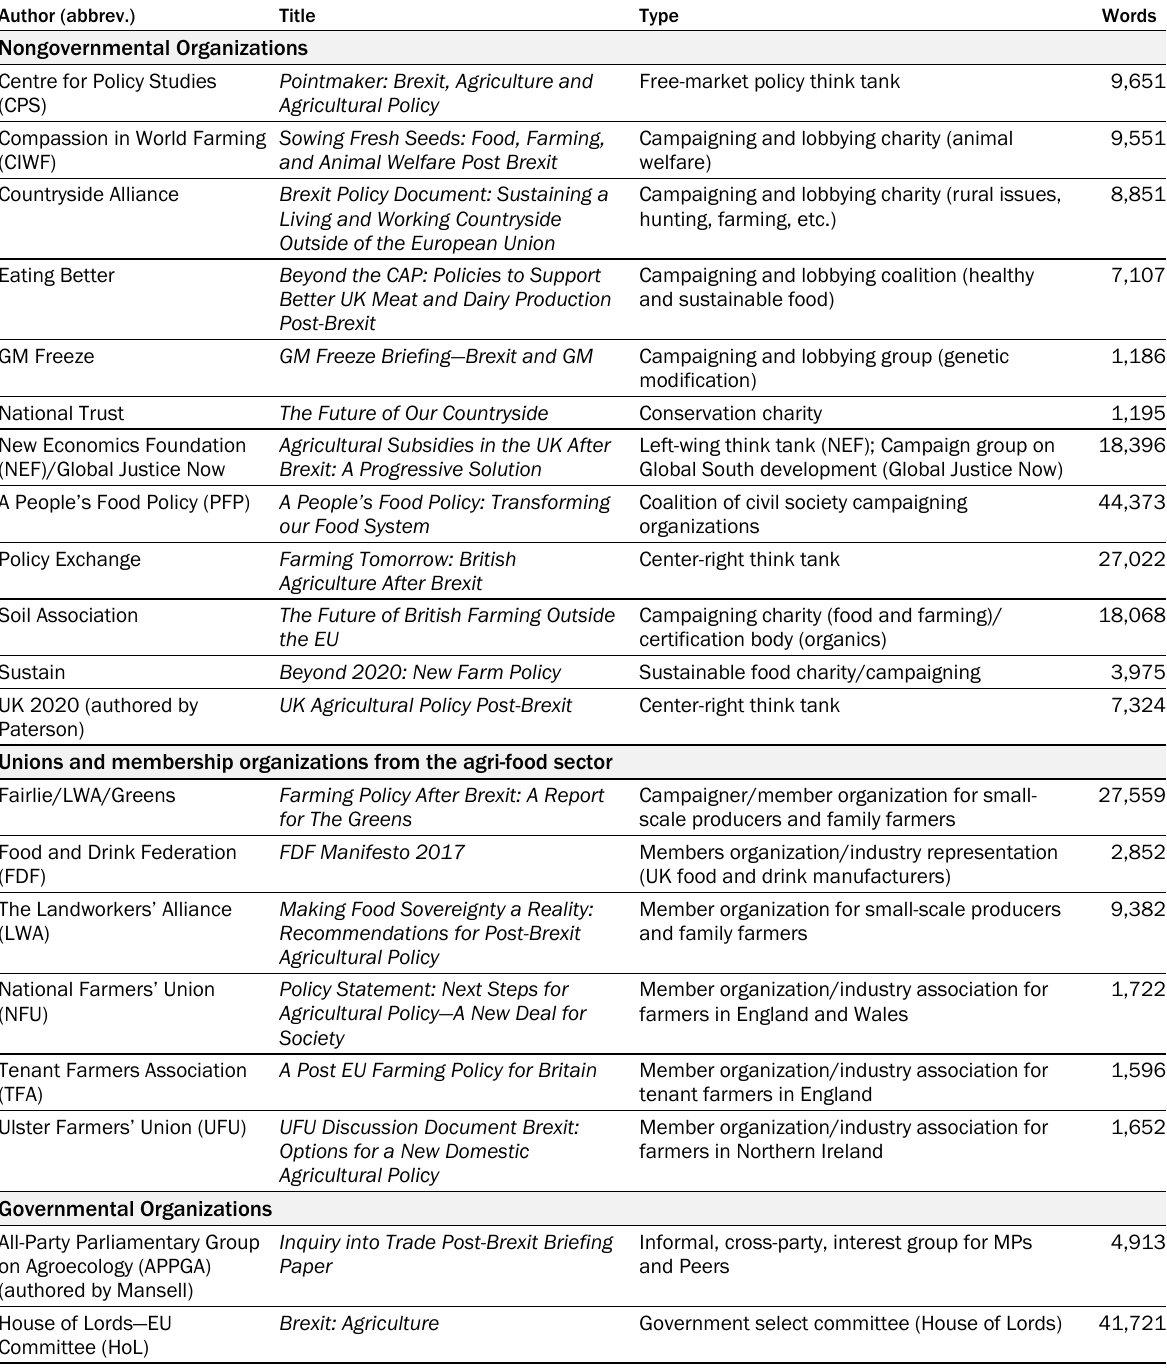
Table 1. Characterization of the 20 Documents, Their Authors, Organization Type, and Principal Aims Author